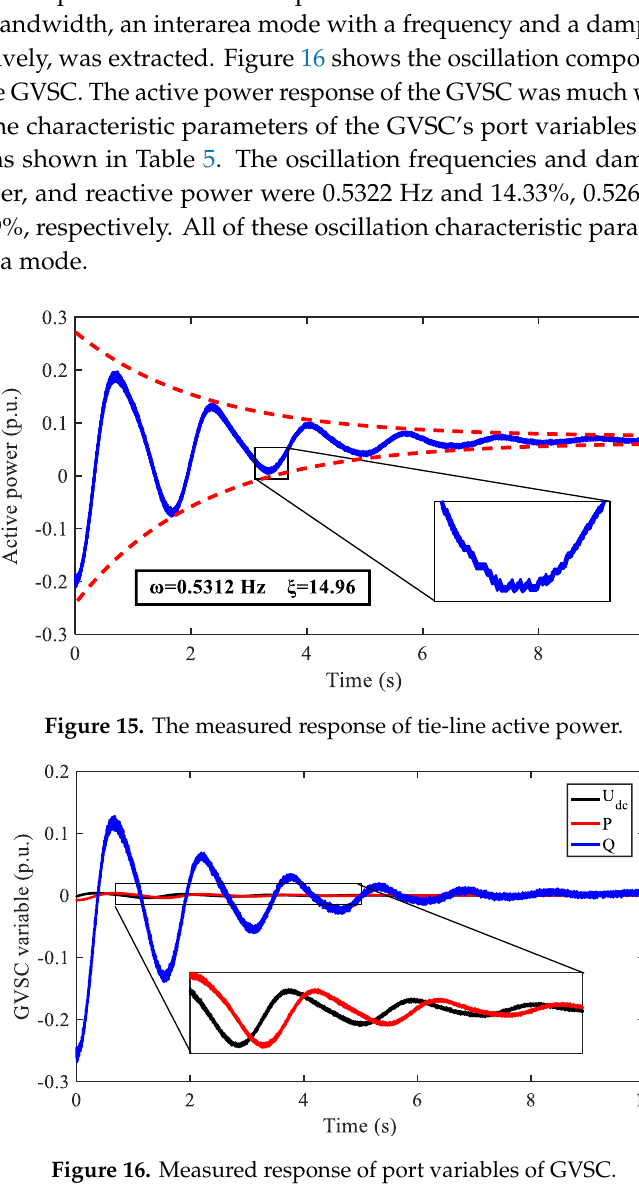
Figure 16. Measured response of port variables of GVSC. Table 5. Oscillation parameters of GVSC port variables.